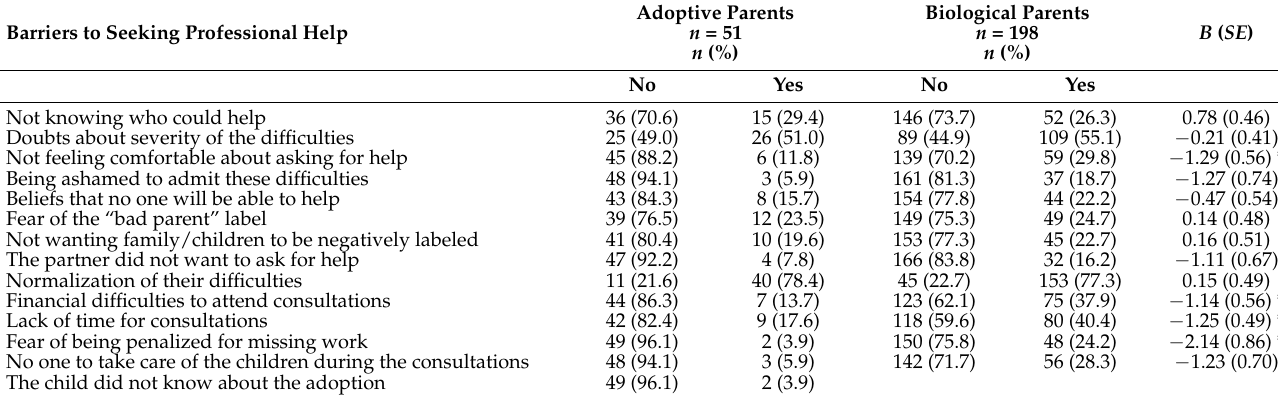
Table 4. Barriers to Seeking Professional Help to Deal with Parental Difficulties, According to Family Type (Adoptive vs. Biological Parents): Descriptive Statistics and Group